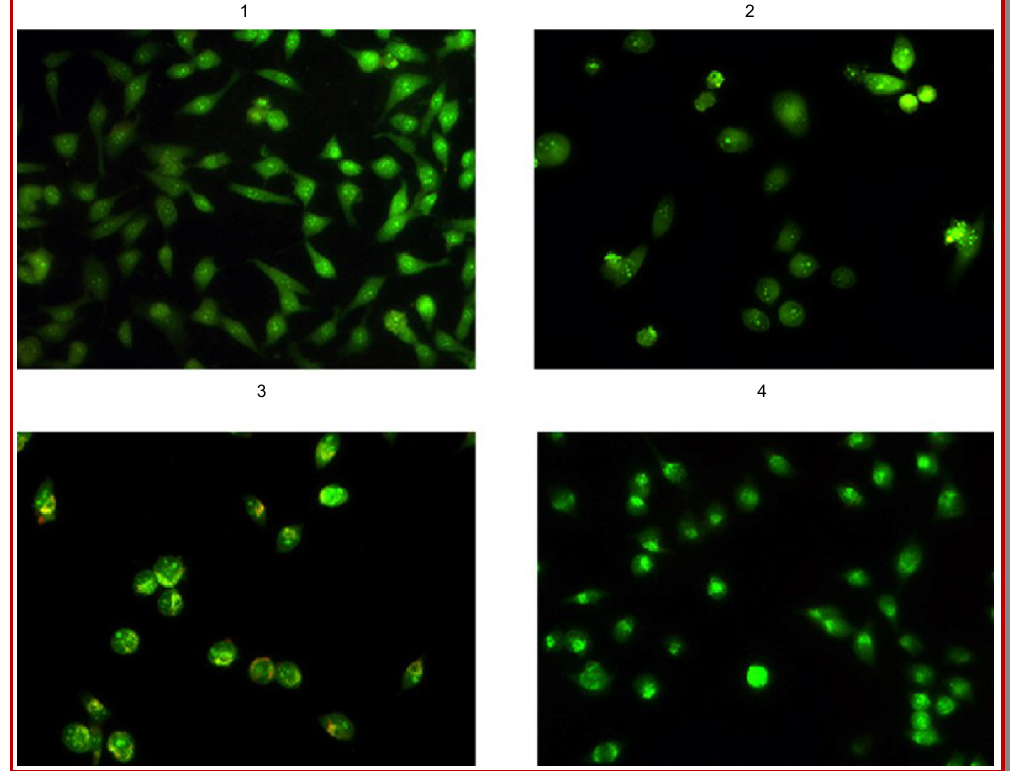
Figure 1: Photomicrographs of acridine orange/ethidium bromide stained HeLa cells (A): 1-control HeLa cells, 2- HeLa cells treat- ed with cisplatin, 3- HeLa cells treated with water extract of M. aquifolium , 4- HeLa cells treated with ethanol extract of M.